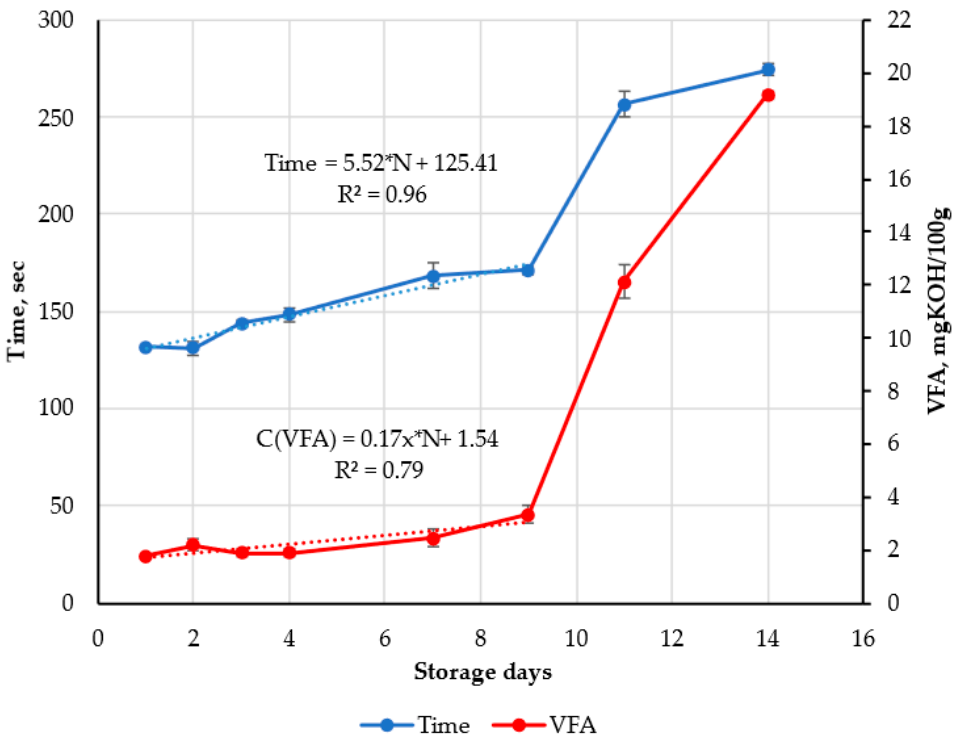
Figure 7. Temporal change of the index Time obtained with FPMLC device and VFA content during storage of minced pork at +4 °C under aerobic conditions.